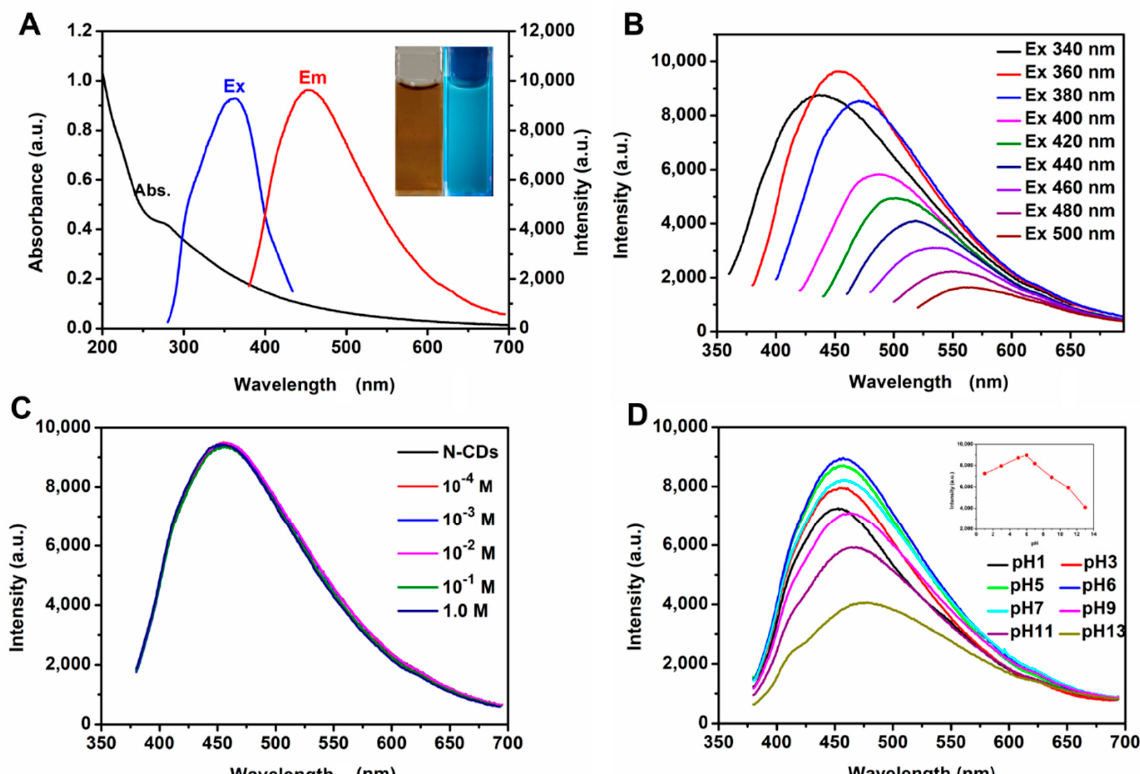
Figure 3. ( A ) UV–vis absorption spectra (black), excitation (blue) and emission (red) spectra of N–CDs. Inset: photographs of aqueous solutions under visible light (left) and 365 nm light UV (right); ( B ) Fluorescent emission spectra of N–CD aqueous solution under various excitation wavelengths ranging from 340 nm to 500 nm; ( C ) Fluorescent spectra of N–CDs in different concentrations of sodium chloride; ( D ) Fluorescent spectra of N–CDs at different pH